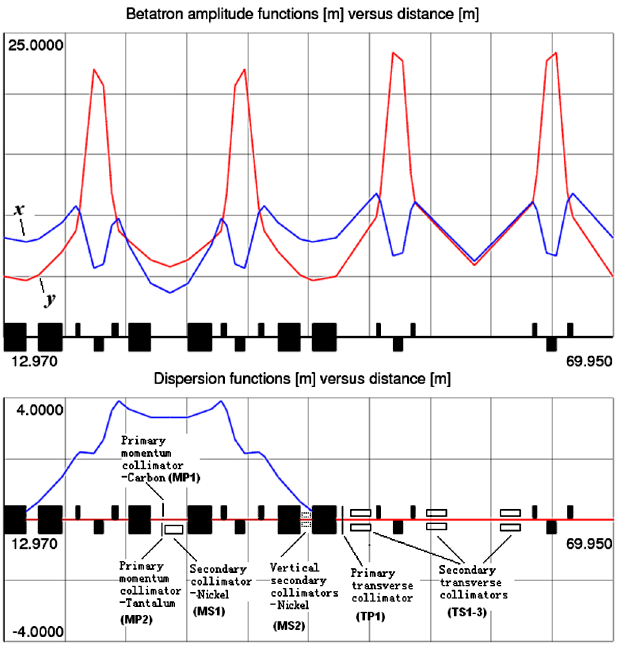
FIG. 4. Lattice structure and the layout of the transverse colli- mators and the momentum collimators at the CSNS